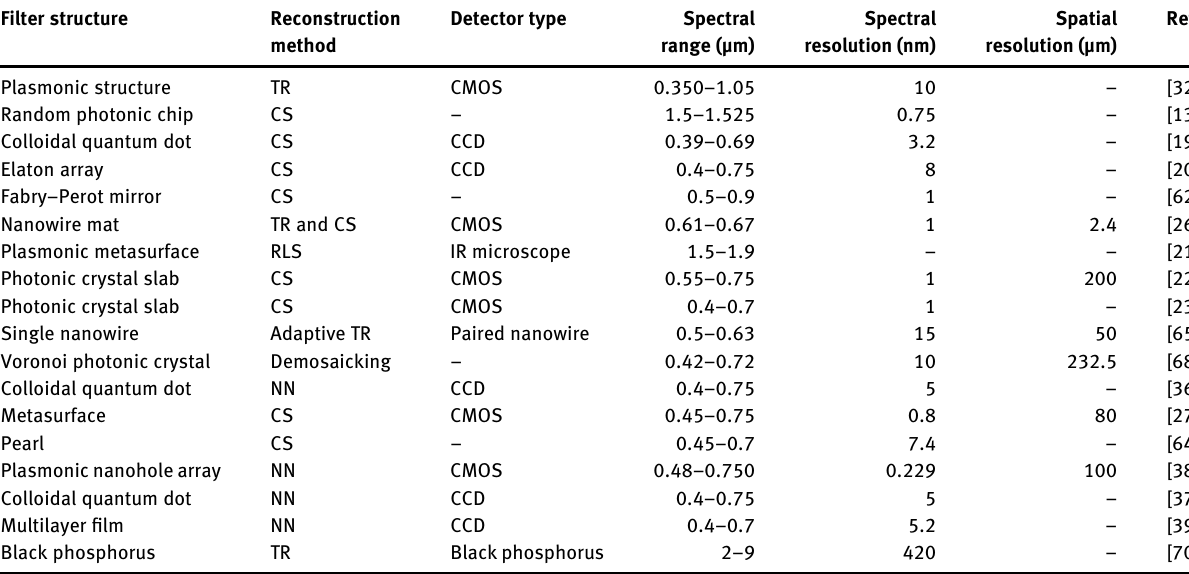
Table  : The performance comparison of some recent computational spectrometers. Filter